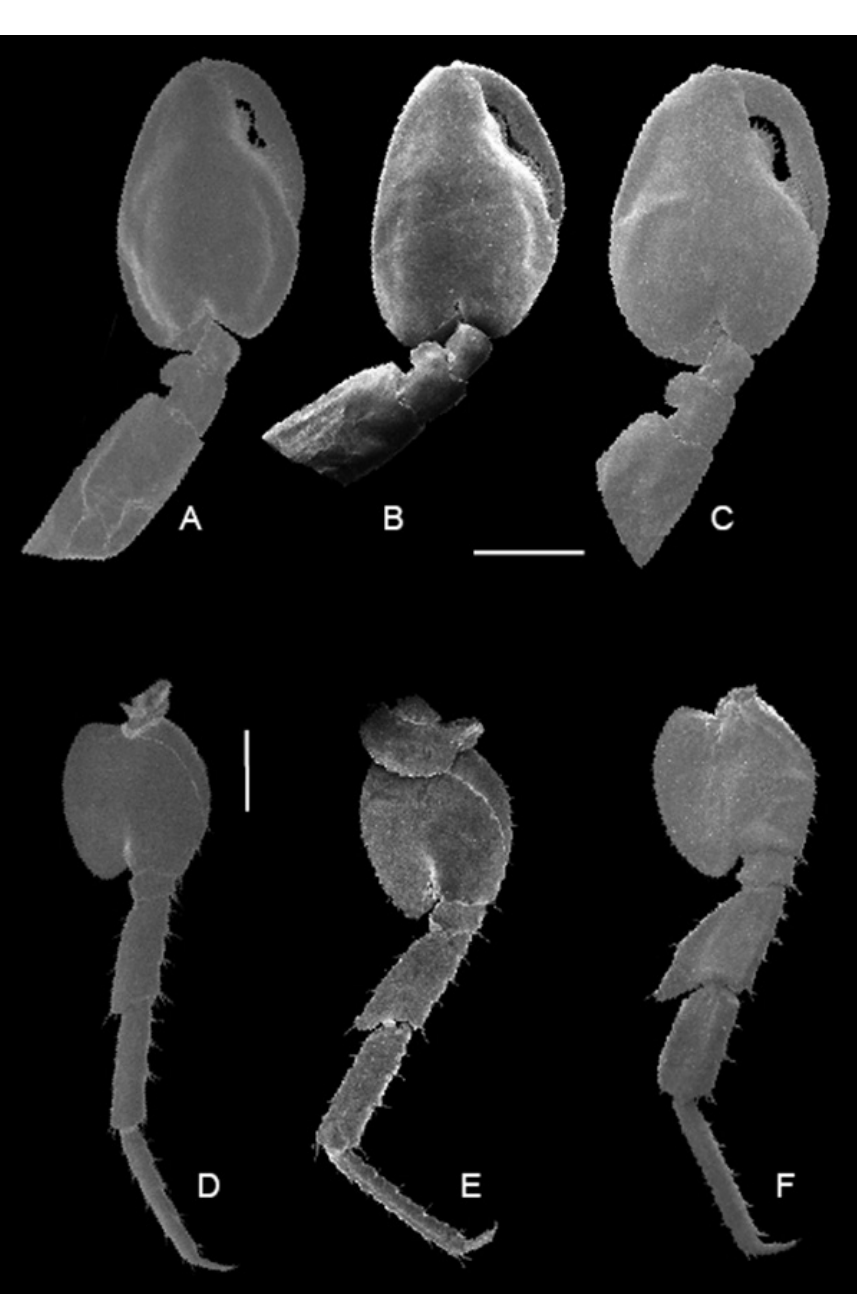
Figure 9. A Cryptorchestia ruffoi sp. n., gnathopod 2 male, 11.1 mm total body length B Cryptorchestia garbinii from Lake Garda, gnathopod 2 male, 18 mm total body length C Cryptorchestia cavimana from Cyprus, gnathopod 2 male, 14. 8 mm total body length, scale bar 1 mm. D Cryptorchestia ruffoi sp. n. pereopod 7 male E Cryptorchestia garbinii from Lake Garda, pereopod 7 male F Cryptorchestia cavimana from Cyprus, gnathopod 2 male, scale bar 1